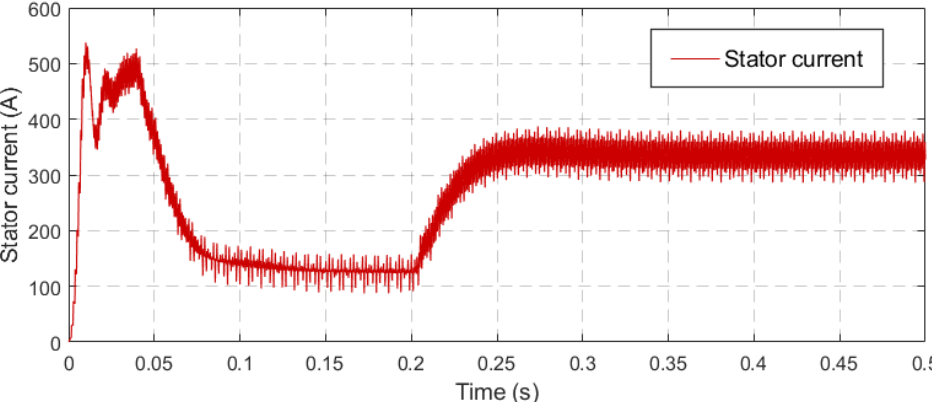
Figure 22. The stator current before and after a rated load torque step is applied at t = 0.2 s.